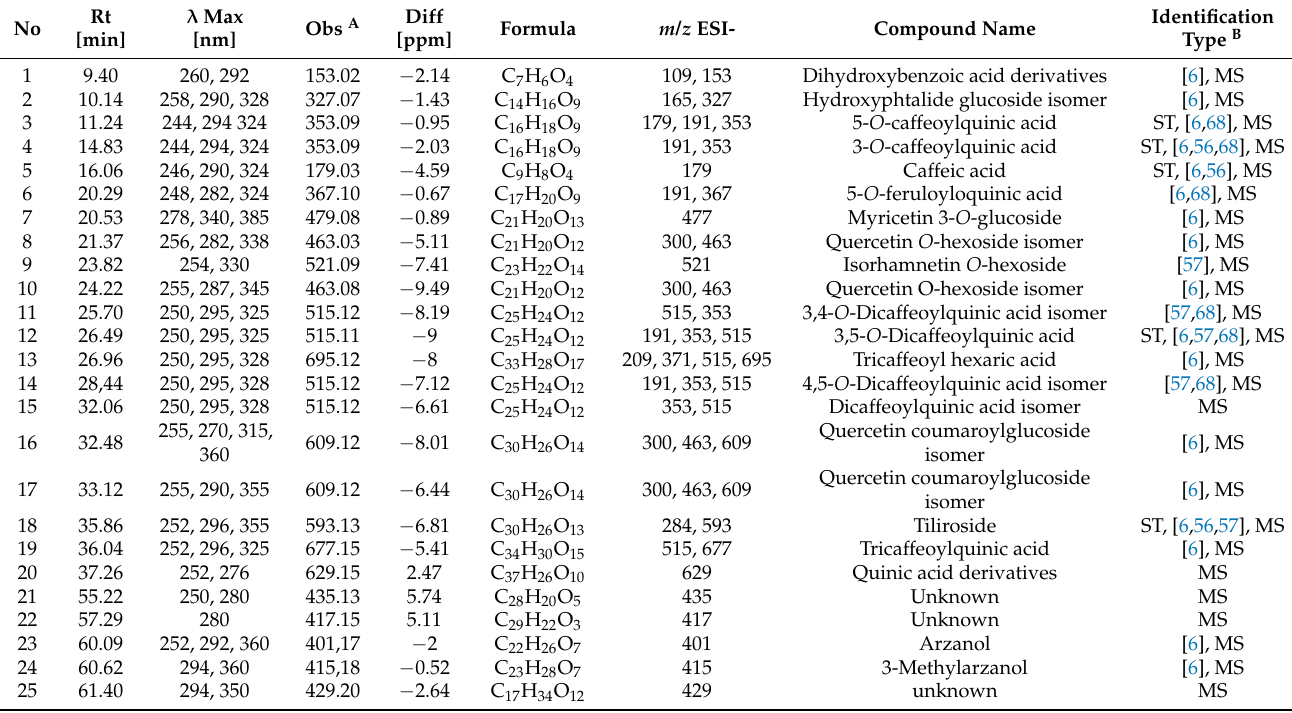
Table 7. The spectroscopic data for the compounds observed in H. italicum extracts obtained with